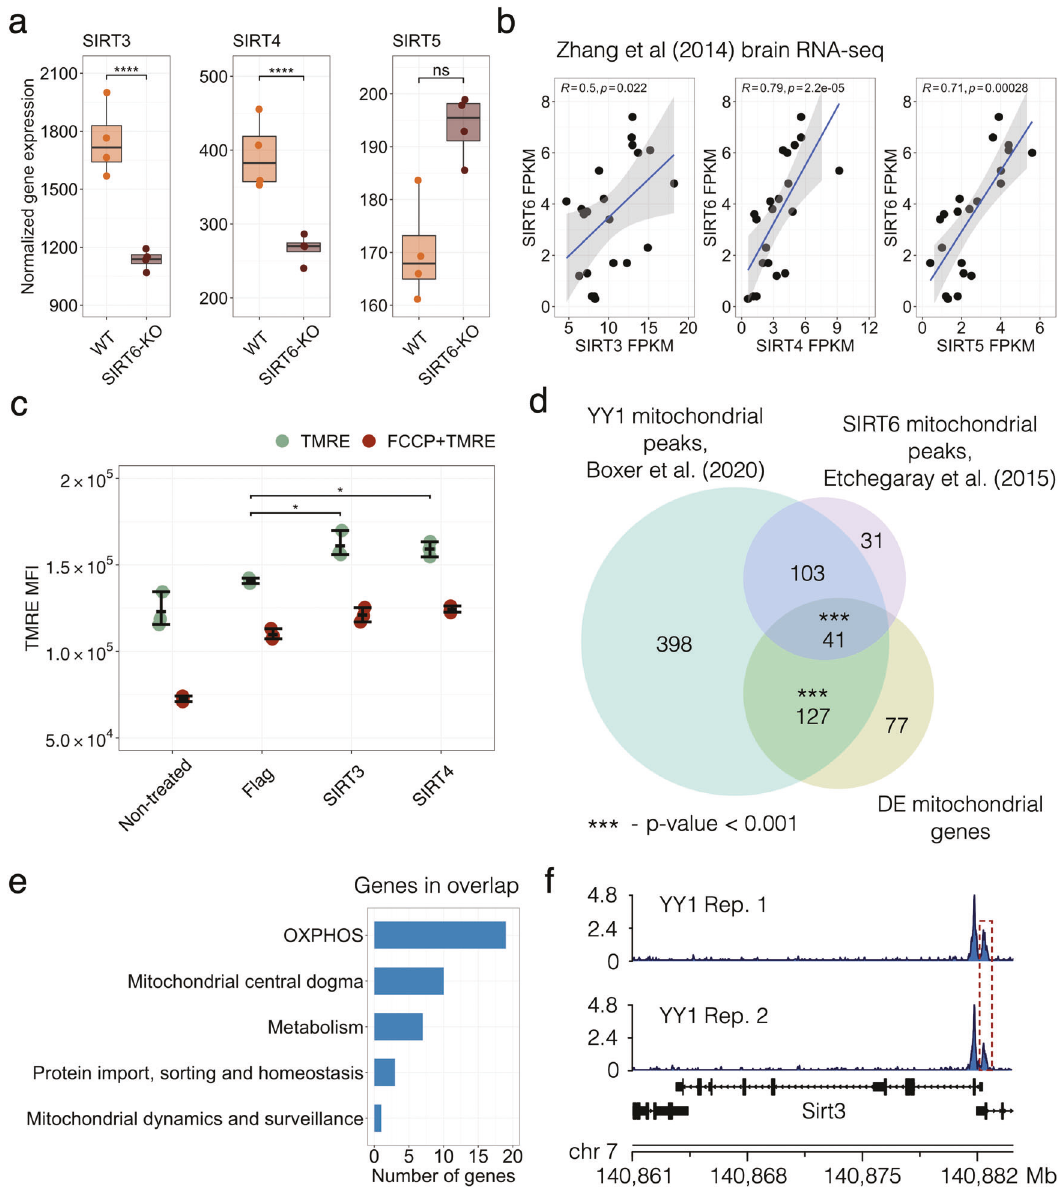
Fig. 4 SIRT6-SIRT4 and SIRT6-YY1 axes in mitochondrial regulation. a SIRT3-5 expression levels in transcriptomic pro fi les of WT and SIRT6- KO mice. Asterisks indicate the statistical signi fi cance (FDR p value < 0.05) derived from DESeq2 differential expression analysis. b Spearman ’ s overexpressed. SIRT6-KO SH-SY5Y cells were transfected with Flag-CMV, SIRT3-Flag-CMV, and SIRT4-Flag-CMV plasmids. After 48 h, cells were collected and stained with TMRE and Life/dead viability dye and the intensity of fl uorescence was measured by CytoFLEX. d Venn diagram showing overlaps between signi fi cant mitochondria-related genes from the RNA-seq analysis (orange), YY1 mitochondrial targets (green) and SIRT6 mitochondrial targets (purple). Statistical signi fi cance of the overlaps was calculated using the permutation test. e Bar plot